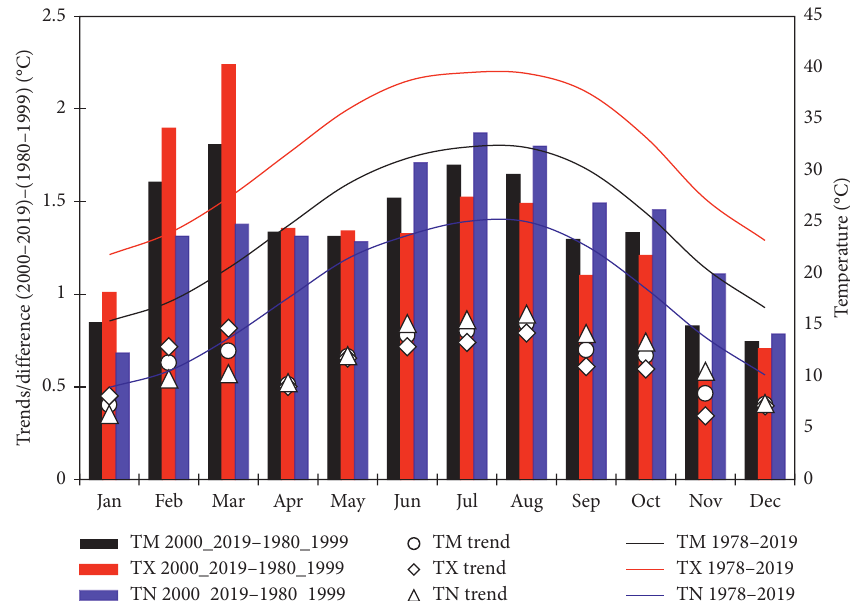
Figure 4: Annual cycle of the country-averaged temperature linear trends (mean TM, circle; maximum TX, diamond; and minimum TN, a triangle with unit ° C per decade) and the temperature difference between 2000–2019 and 1980–1999 (bars: mean, green; maximum, red; and minimum, blue with unit ° C) along with temperature climatology (lines: mean, black; maximum, red; and minimum, blue) in Saudi Arabia for the period